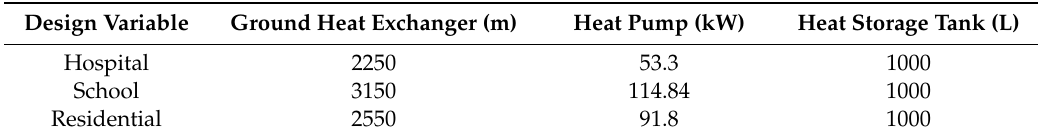
Table 5. Design values for